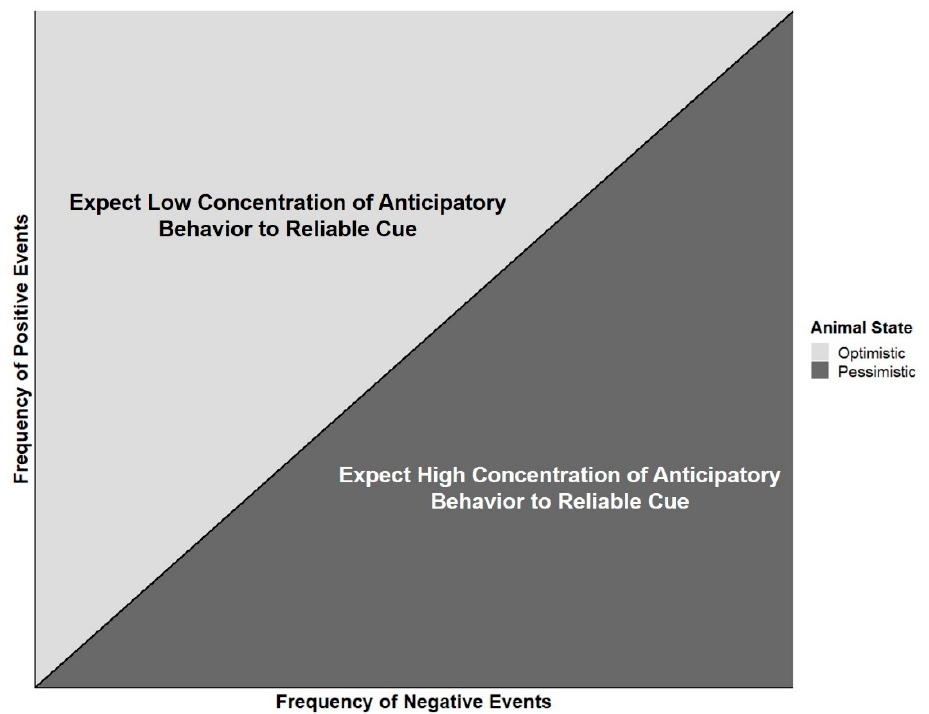
Figure 3. Graphical model of how the ratio between the frequency of positive and negative events influences animal responses to reliable (anticipatory response) or equivocal (optimistic or pessimistic judgment bias response) cues.